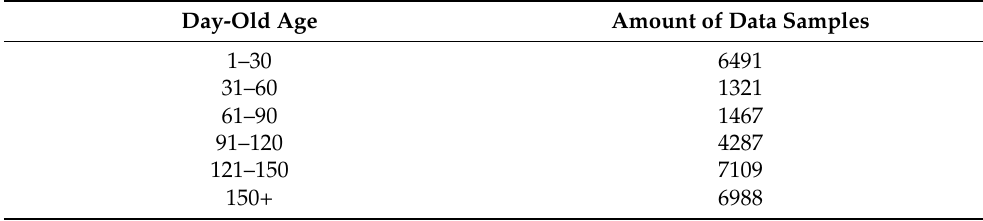
Figure 1. Exhibition of the chicken dataset. ( A – D ) represent day-old chickens from different sub-datasets. Table 2. Data samples’ distribution of the dataset.